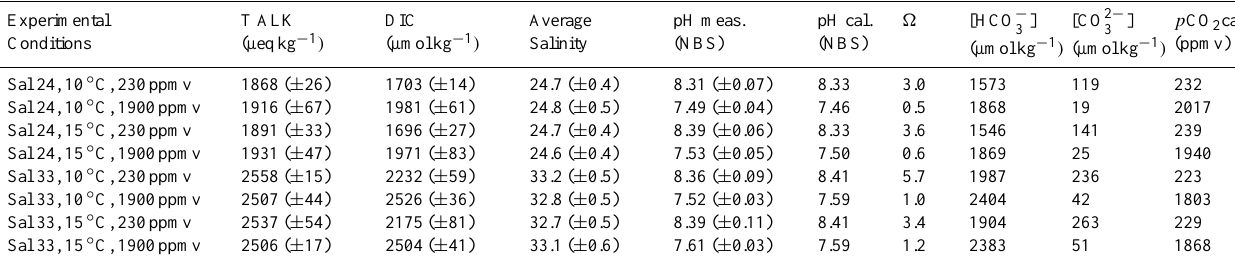
Table 1. Carbonate chemistry of the culture media. Experiments ran for one and a half months. Alkalinity and DIC were analysed every two weeks, salinity and pH every second day. Numbers represent average values of Alkalinity, DIC, salinity and pH measured for each experimental condition. (cid:127) , [HCO − ], [CO 2 − ], pH cal., and p CO 2 cal. were calculated with the CO 2 Sys program (Lewis and Wallace, 1998) 3 3 from measured alkalinity, DIC, temperature and salinity.